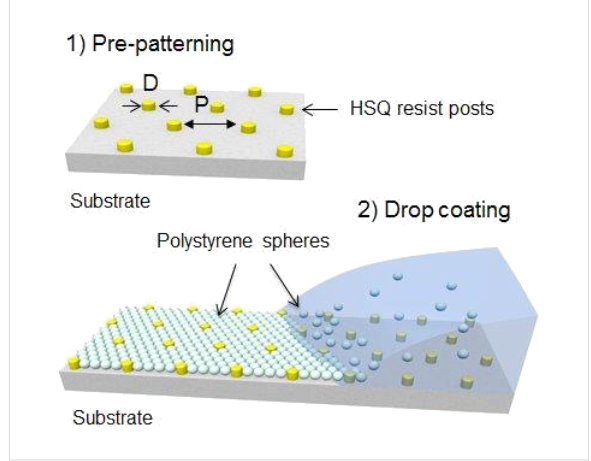
Figure 1: Large-scale topology assisted organization: Schematic representation of the particle (PS beads) assembly process driven by the liquid flow on a pre-patterned substrate with D and P corres- ponding to the post diameter and pitch,